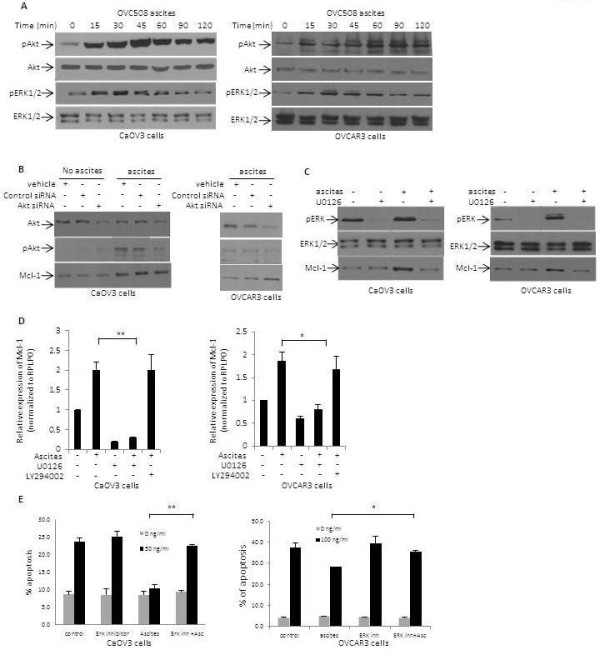
ERK1/2 signaling regulates the Mcl-1 expression. (A) Immunoblot analysis of Akt, phospho-Akt, ERK1/2 and phospho-ERK1/2 in CaOV3 and OVCAR3 cells following the addition of 10% OVC508 ascites. (B) Expression levels of Akt, phospho-Akt and Mcl-1 in vehicle, Akt or control siRNA-transfected CaOV3 and OVCAR3 cells 24 h post-transfection in the presence or absence of OVC508 ascites. (C) Immunoblot analysis of ERK1/2, phospho-ERK1/2 and Mcl-1 in OVC508 ascites- and U0126-treated OVCAR3 and CaOV3 cells 24 h post treatement. (D) Real-time PCR analysis of Mcl-1 transcript levels in CaOV3 and OVCAR3 cells. Cells were treated with either ascites (OVC508), MEK1/2 inhibitor U0126 or Akt inhibitor LY294002 and RNA was extracted 4 h later. Results were standardized using primers of the housekeeping gene RPLPO. Results are expressed as fold change relative to basal levels observed in cells incubated in the absence of ascites. (E) Apoptosis was assessed 24 h following incubation with U0126 in the presence or absence of TRAIL 50 ng/ml for CaOV3 cells and 100 ng/ml for OVCAR3 cells. Data shown are means ± SEM derived from three independent experiments. * indicates P < 0.001, ** P < 0.0001.